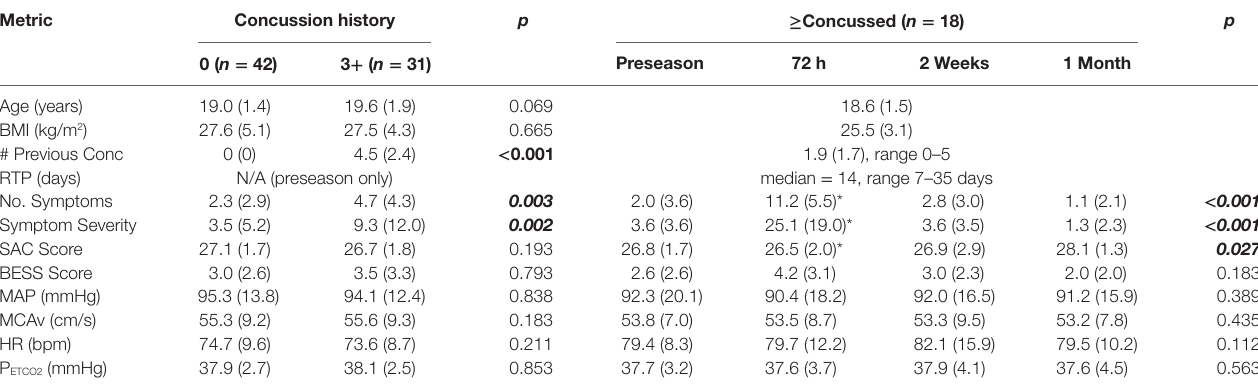
Table 1 | Demographics, SCAT3 performance, and resting physiological parameters at preseason for athletes with no previous concussions or 3 + previous concussions ( left side ) and during each test session for acutely concussed athletes ( right side ).